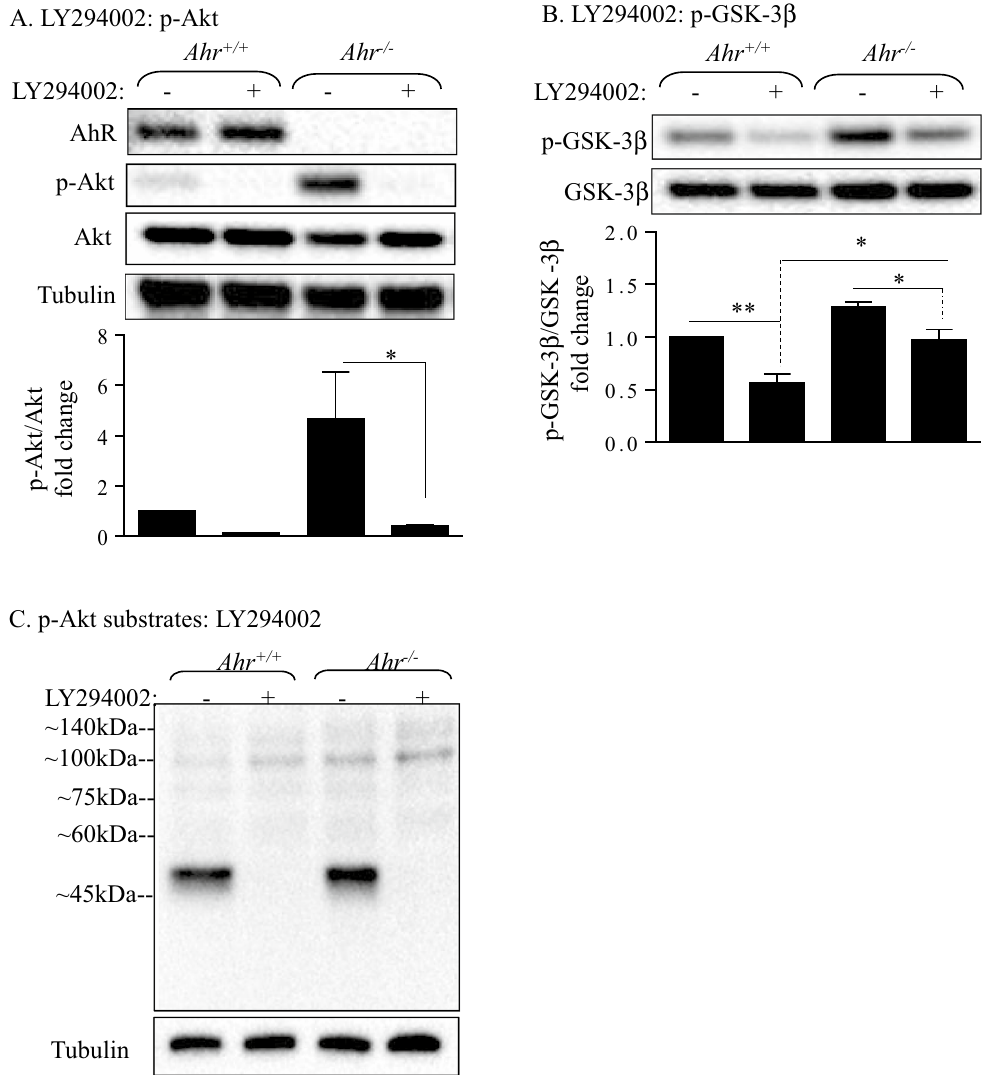
Figure 6. Effect of LY294002 the Akt pathway on Ahr +/+ and Ahr −/− MLFs. ( A , B ) Ahr +/+ and Ahr −/− MLFs were treated with either 50 μM LY294002 or the vehicle control (DMSO) for 2 h and cellular protein was collected for Western blot analysis of ( A ) Akt and ( B ) GSK-3β phosphorylation. Depicted blots are representative of three independent experiments. Results are expressed as mean ± SEM. ( C ) Serum-starved Ahr +/+ a nd Ahr −/− MLFs were treated with LY294002 for 2 h and cellular protein was collected for western blot analysis of Akt substrate phosphorylation. Depicted blots are representative of three independent